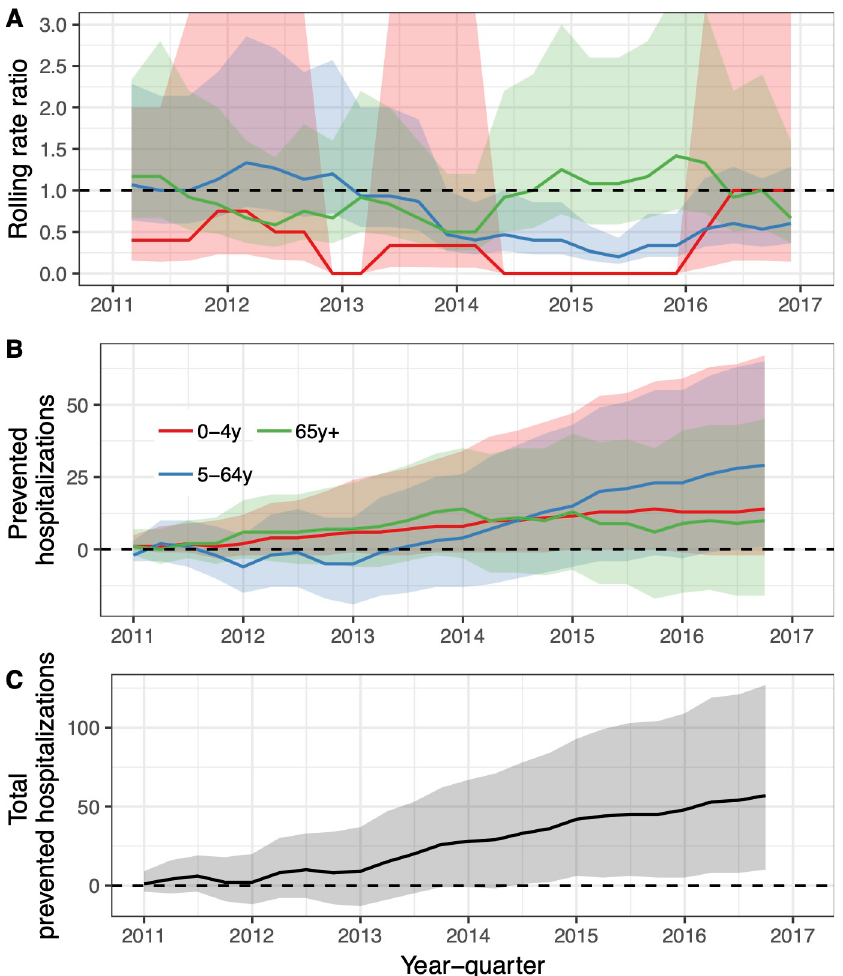
Fig 6. The population impact of the vaccine (PHiD-CV10) on hospital admissions for invasive pneumococcal disease. In Panel A, the estimated 12-month rolling rate ratio between the observed and the predicted number of IPD hospitalisations in the post-vaccine period (2011–2016) is shown per age-group. In some 12-month periods, no IPD hospitalisations were observed, and the resulting rate ratio was zero regardless of the denominator. In other periods, 2.5% or more of the MCMC draws predicted zero IPD hospitalisations, which resulted in a 95% credible intervals of the rate ratio that extended towards infinity. These issues do not change the overall interpretation of the prediction line presented. Panel B depicts the cumulative number of prevented IPD hospitalisations during the post-vaccine period (2011–2015) for each age-group. https://doi.org/10.1371/journal.pone.0249497.g006 Table 5. The rate ratio between observed and predicted number of hospital admissions for Invasive Pneumococcal Disease (IPD) during the post-vaccine period (2013–2016). Age-group Rate ratio (95% CI)